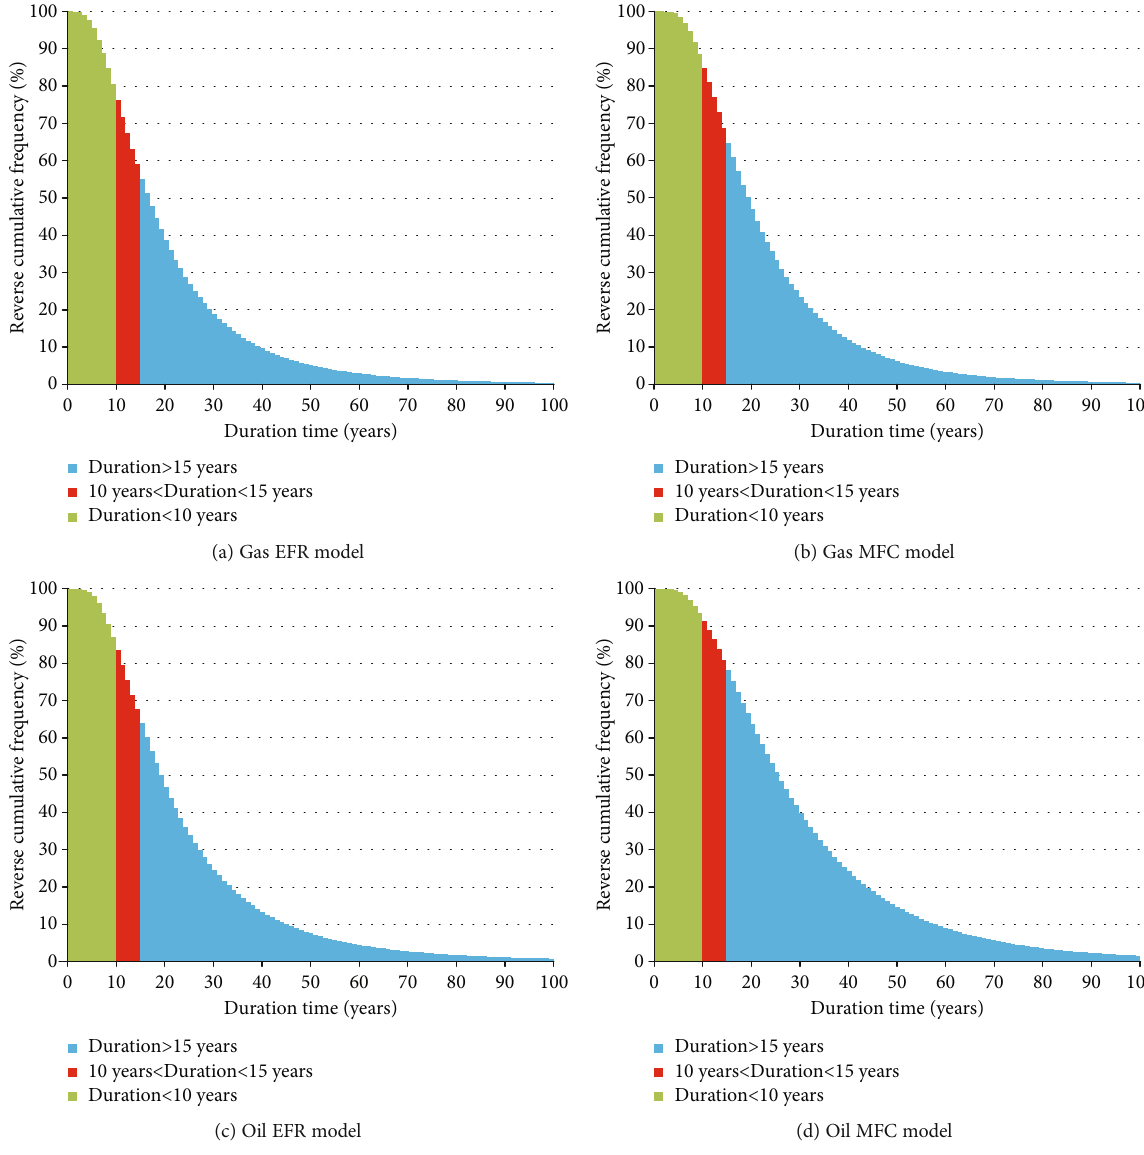
Figure 2: Time duration of linear fl ow of di ff erent fl uid phases and